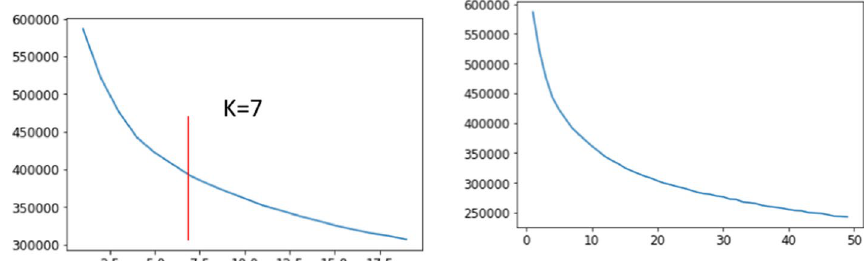
Fig. 7 Elbow plots used to analyse values of k